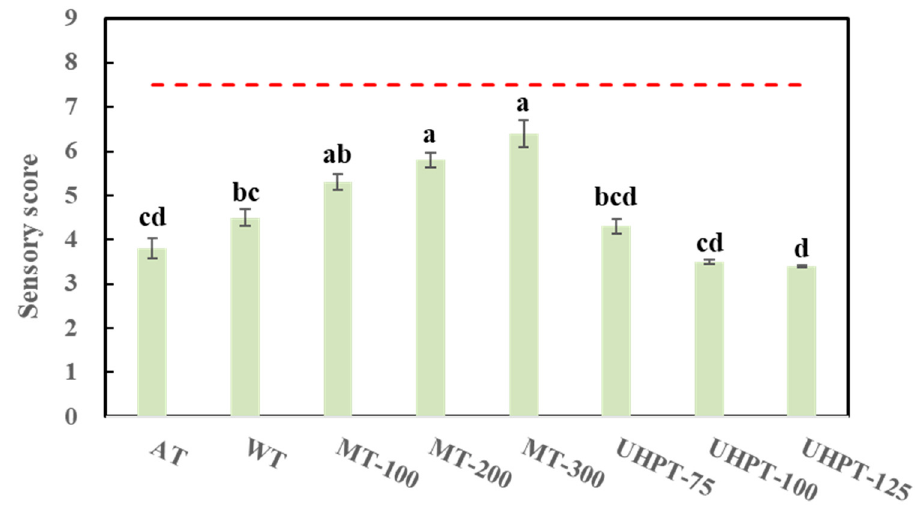
Figure 6. The sensory scores for the overall acceptability of thawed mangoes were affected by different thawing conditions. The dotted line represents the sensory score of the fresh mango. The different lowercase letters mean the significant difference among thawing conditions ( p < 0.05).